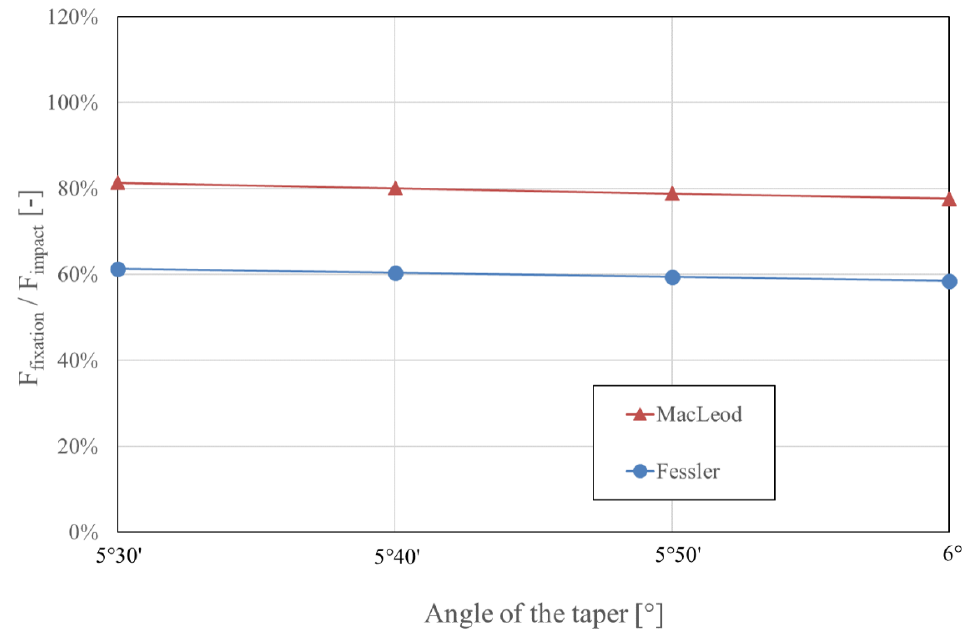
Figure 2. Influence of the angle of the taper on fixation force, as estimated by Fessler and MacLeod’s models. With the impaction force having a linear effect in both models, the fixation force is represented as a proportion of the impaction force. The range of taper angles illustrated covers the range of tapers available commercially in hip arthroplasty. For both models, a coefficient of friction µ of 0.2 was considered. For MacLeod’s estimate, a 32-mm head was considered.